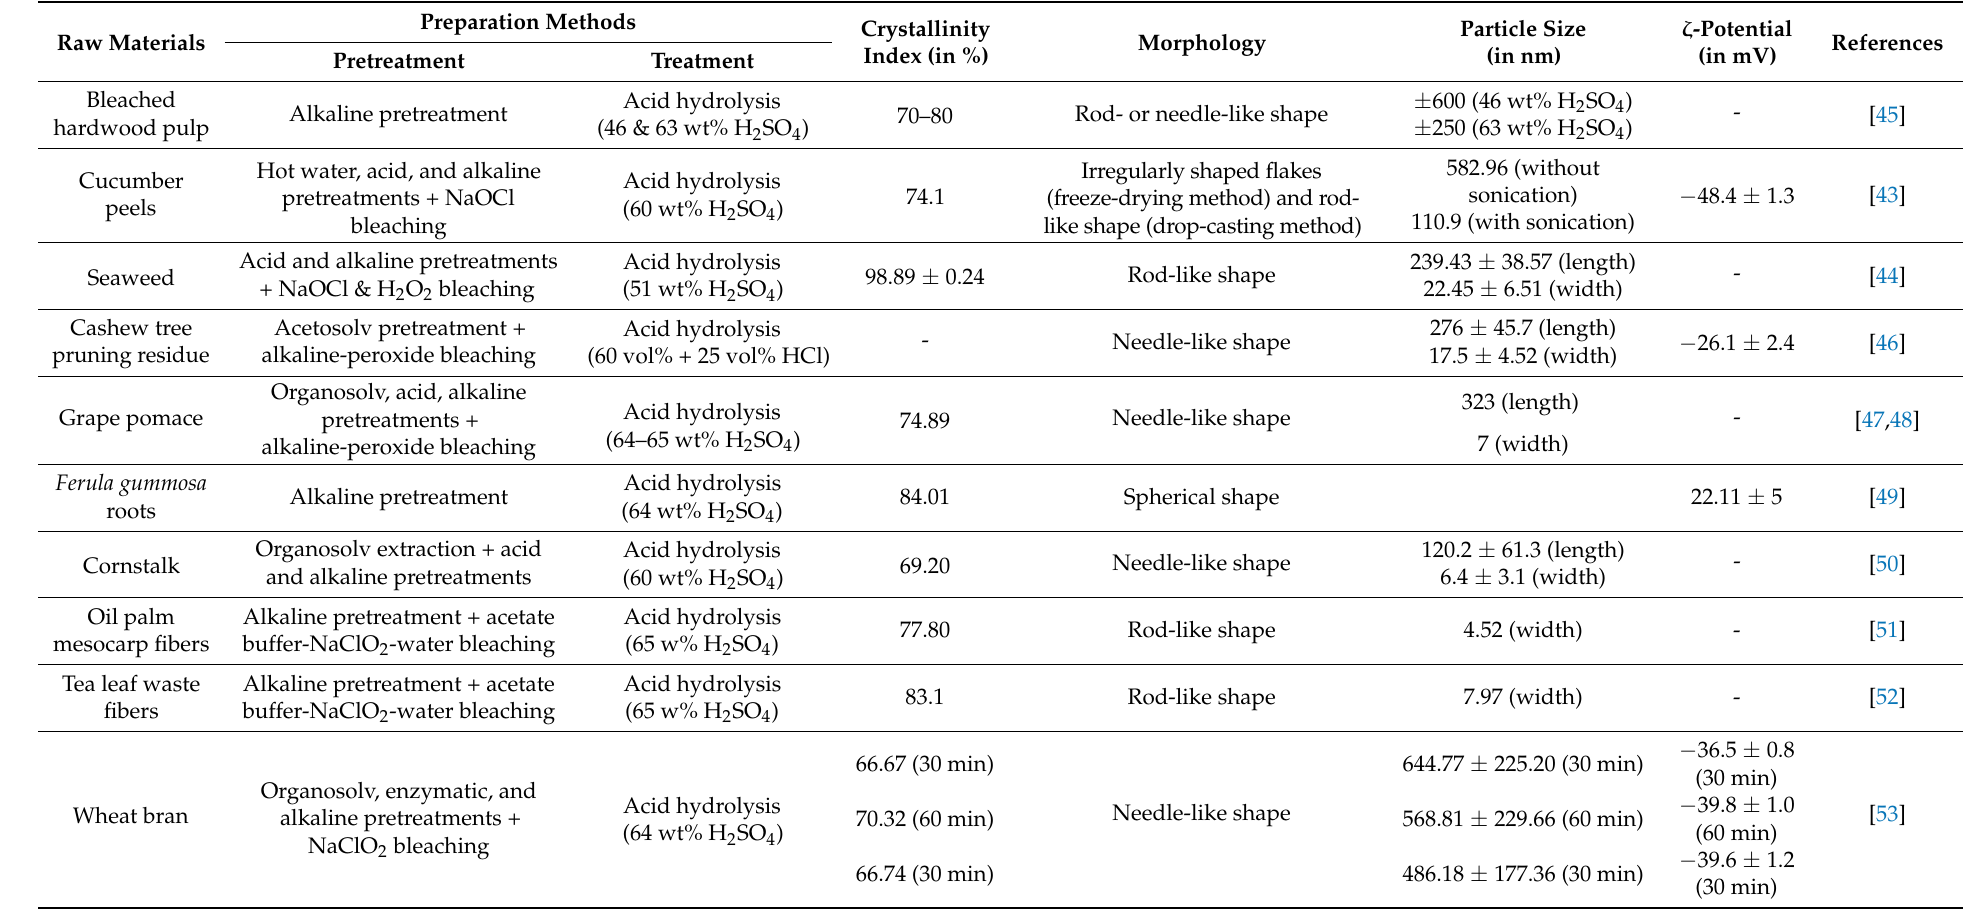
Table 4. Previous studies of CNCs preparation using various raw materials and